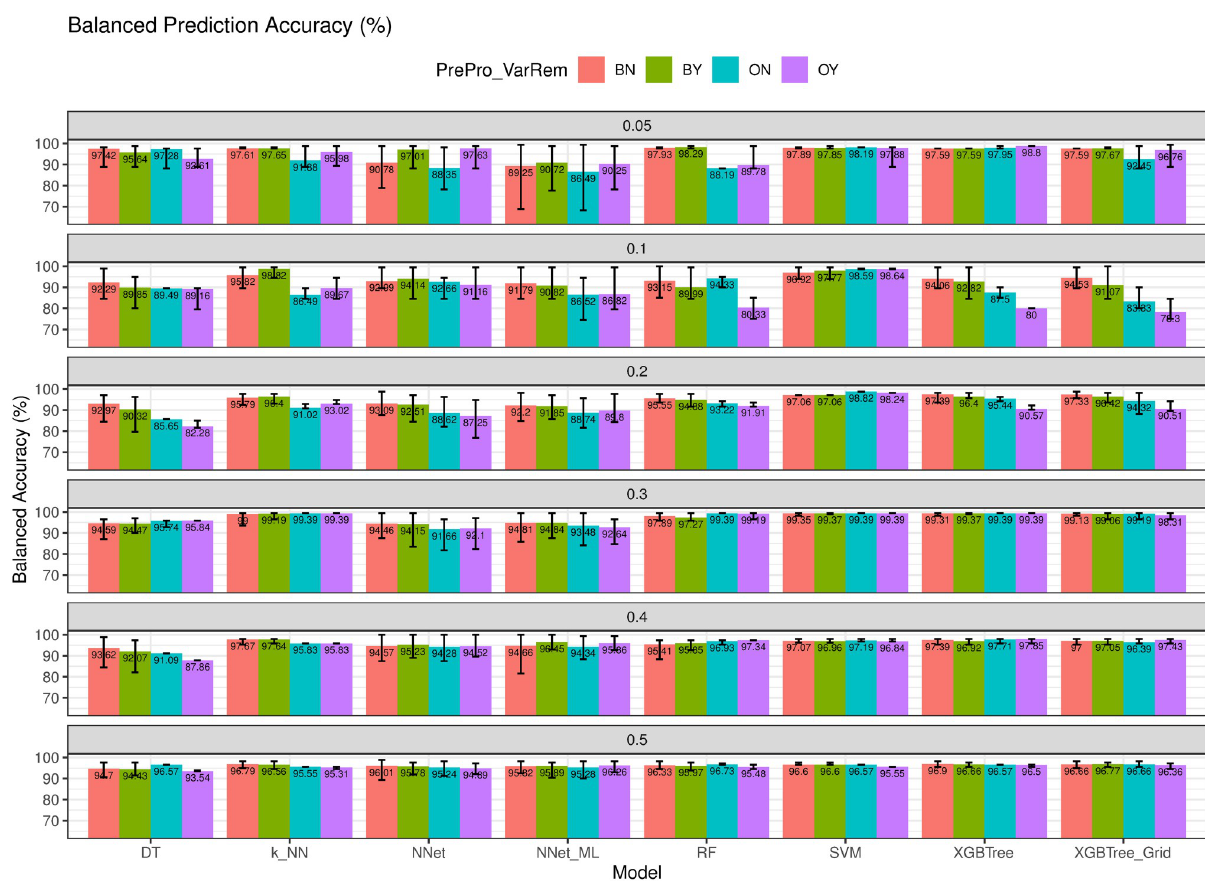
Fig 16. Balanced accuracy with different ratios of minority to majority classes. Models trained with ENUS improved by 2.04% compared with the models trained with the original data.